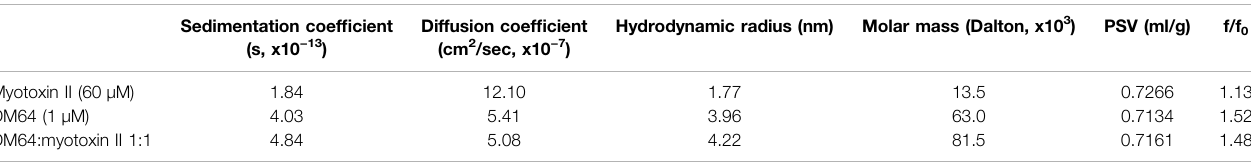
TABLE 1 | Molecular mass determination by sedimentation velocity